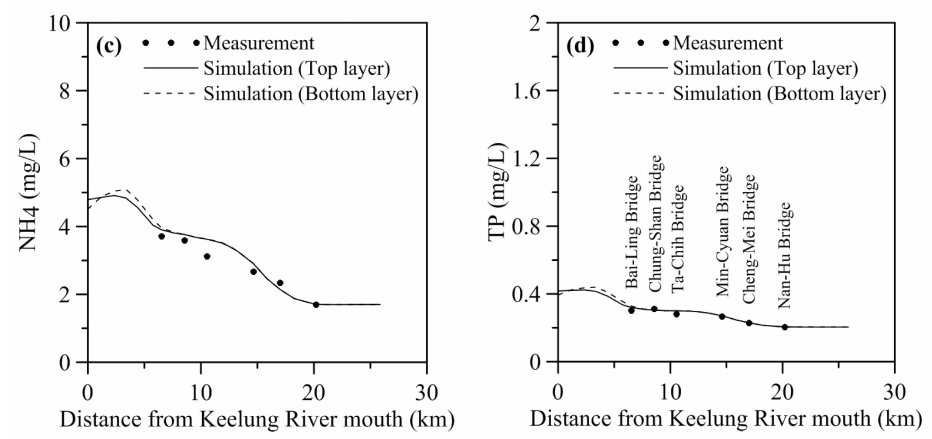
Figure 7. The comparison between the measured and simulated water quality distributions along the Keelung River on 3 March 2011 ( a ) DO; ( b ) CBOD; ( c ) NH 4 ; and ( d ) TP.